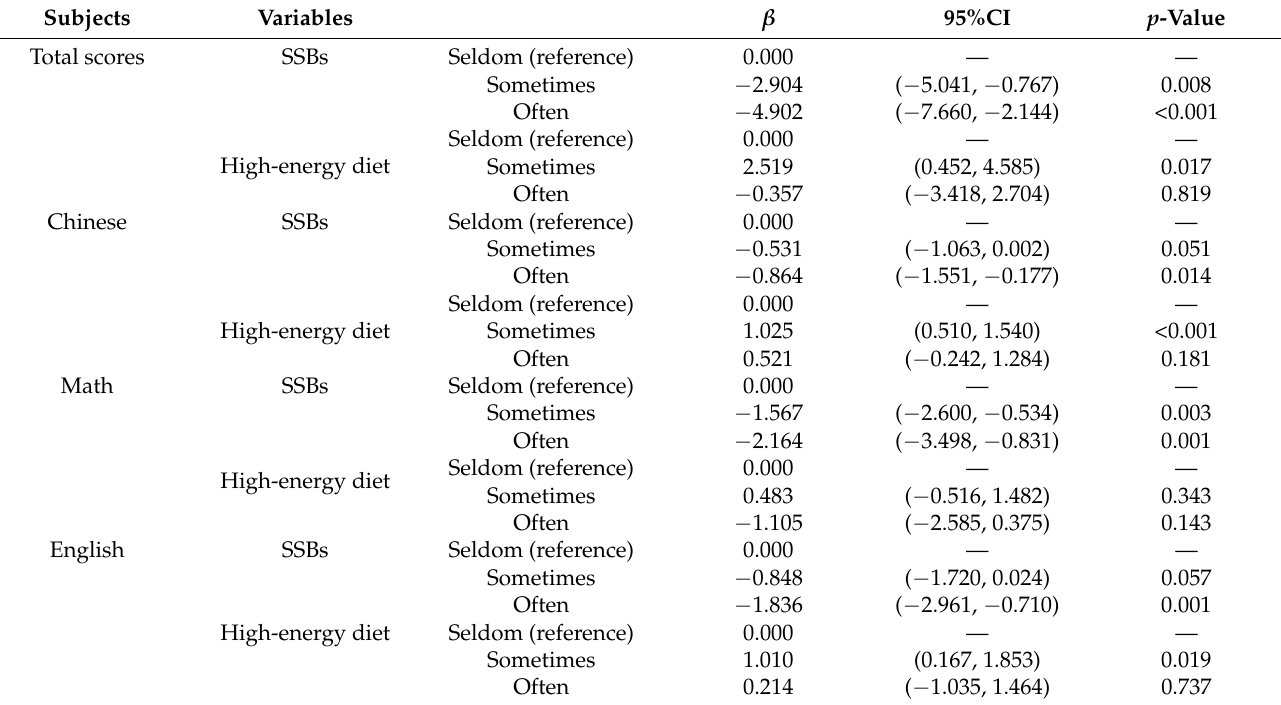
Table 4. Association of SSBs and high-energy diet with total academic scores, Chinese, Math, and English scores from the adjusting GLMM analyses (Model III).